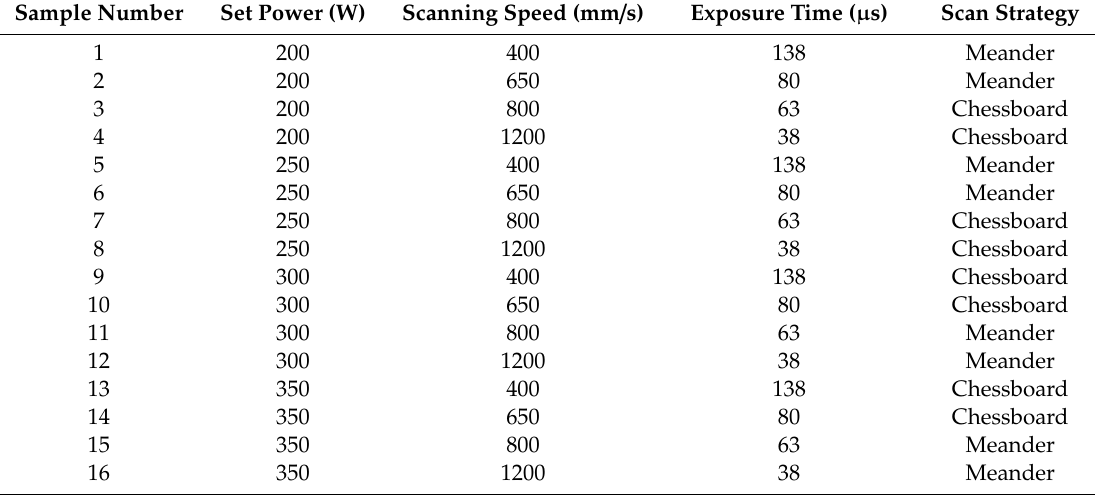
Figure 1. ( a ) selective laser melting (SLM)-prepared rectangular stainless steel sample 5 and ( b ) SLM-prepared cylindrical stainless steel sample 2. Table 1. Conditions used for selective laser melting.